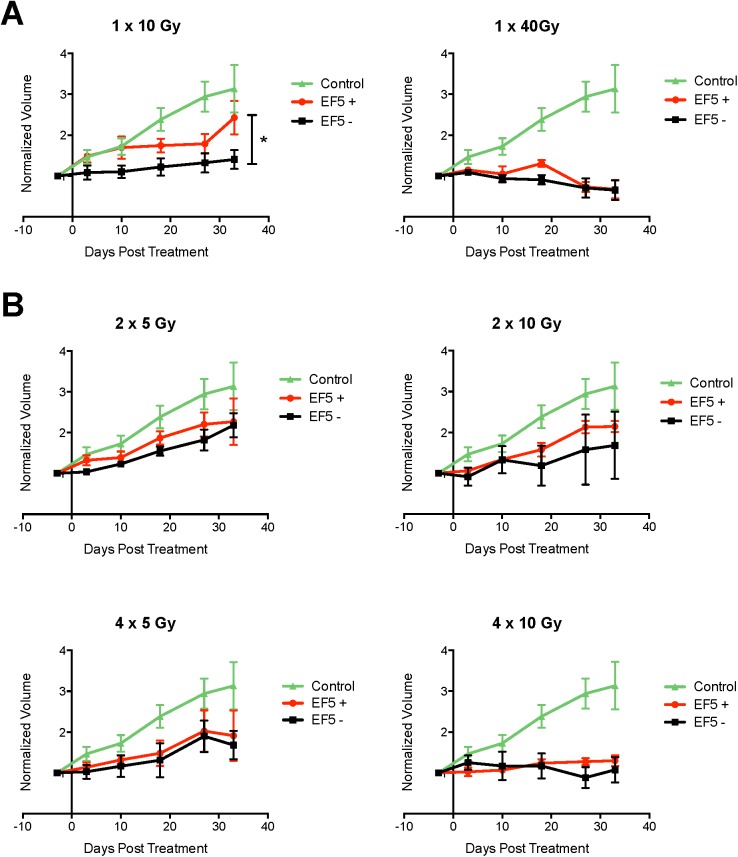
Plots of response of more and less hypoxic tumors to (A) single fraction and (B) multiple fraction treatments.Volumes are normalized to pre-treatment volumes.